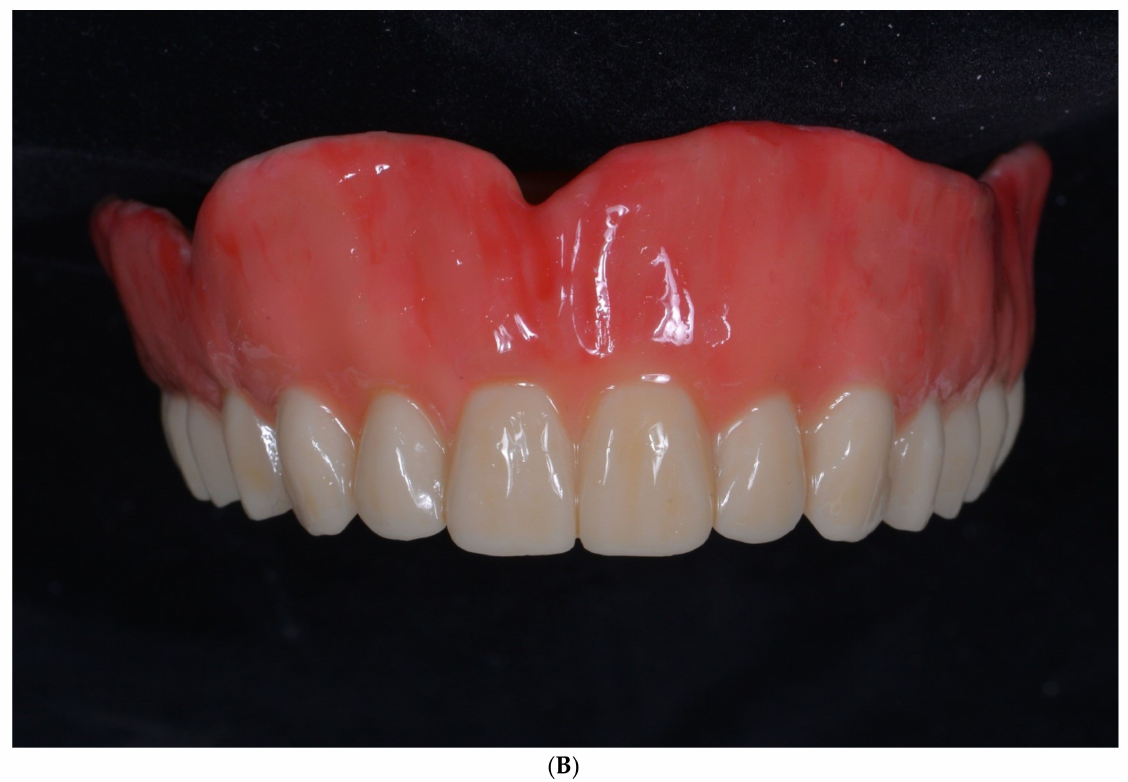
Figure 5. Monolithic printed denture. ( A ): Artificial teeth and denture base are printed in one unit. ( B ): Tissue-colored composite resin is applied onto the denture